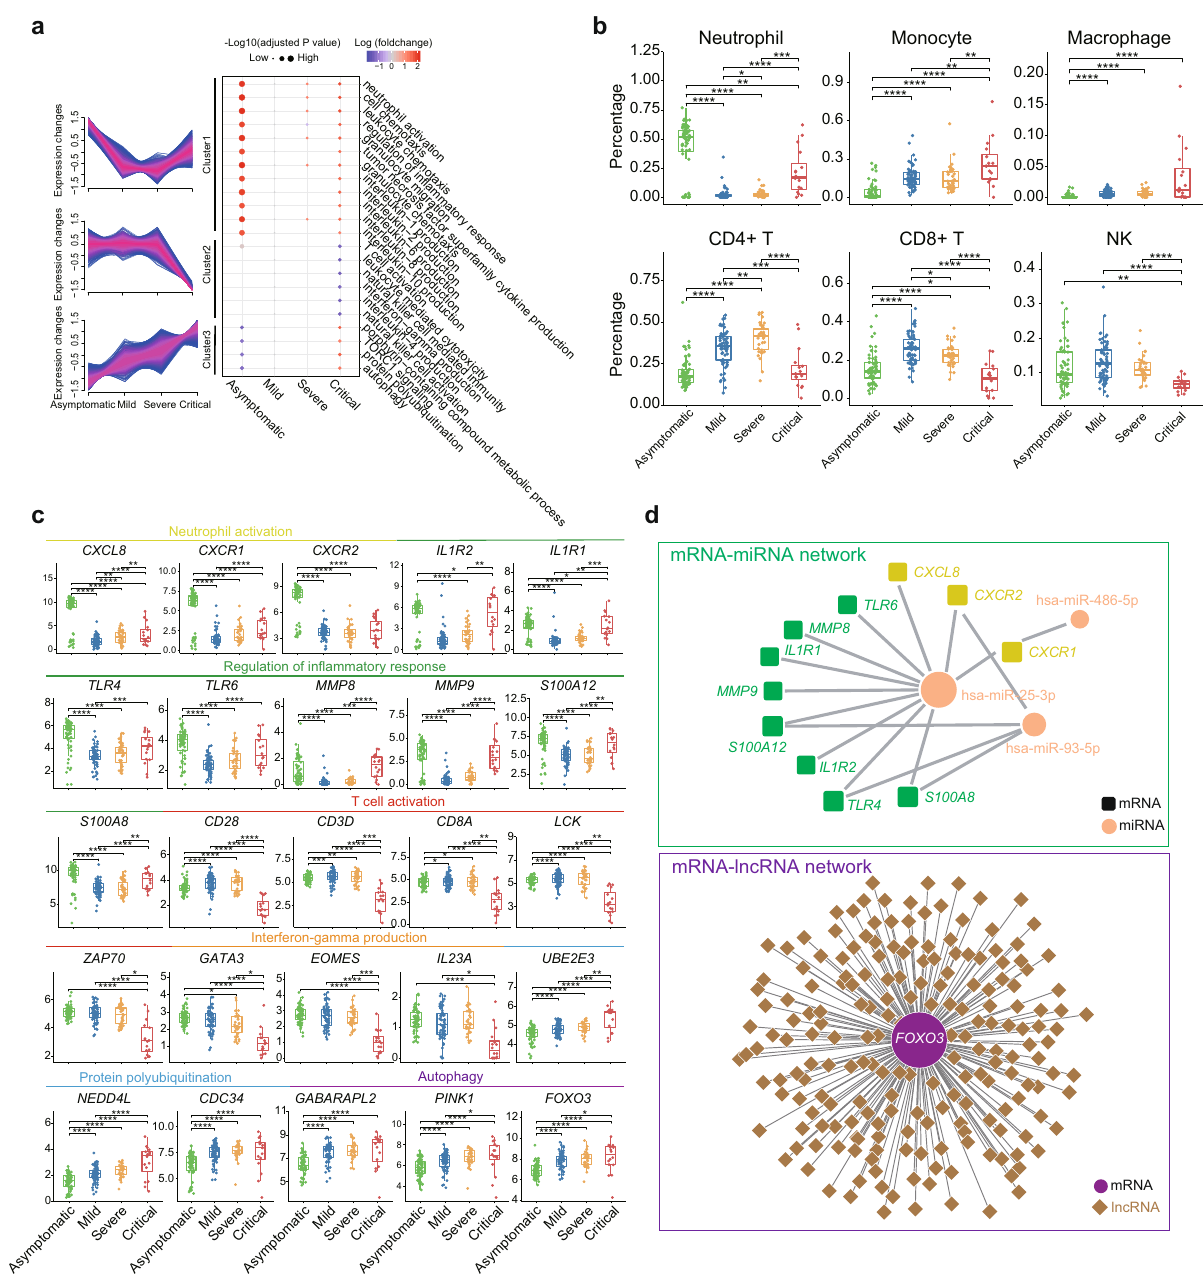
Fig. 2 Transcriptomic hallmarks of COVID-19. a Clustering of differentially expressed mRNAs and bubble plot showing GO terms enriched in each cluster across four disease severity groups. Red and blue represent up-regulation or down-regulation of genes in corresponding GO term in an investigated group compared to mild group (median of log2 (fold-changes)). Dot size represents -log10 (adjusted P values). P values were calculated using hypergeometric test (two-sided). b Estimated immune cell abundance using CIBERSORTx for asymptomatic ( n = 64), mild ( n = 64), severe ( n = 34), and critical ( n = 16) COVID-19 patients. P values were calculated using Wilcoxon signed-rank test (two-sided). c Boxplot of representative genes associated with neutrophil activation, regulation of in fl ammatory response, T cell activation, interferon-gamma production, protein polyubiquitination, and autophagy in asymptomatic ( n = 64), mild ( n = 64), severe ( n = 34), and critical ( n = 16) COVID-19 patients. We performed comparisons between arbitrary two groups. P values were calculated using the Wald test and signi fi cant P values were shown in boxplot. d mRNA-miRNA and mRNA-lncRNA interaction networks for genes mentioned in Fig. 2c. The bold lines, upper boundaries and lower boundaries of notches represent the medians, 75th percentiles and 25th percentiles, respectively. Whiskers extend 1.5 times interquartile range (IQR). * means adjusted P value ≤ 0.05, ** means adjusted P value ≤ 0.01, *** means adjusted P value ≤ 0.001 and **** means P ≤ 0.0001, if not indicated, means adjusted P value > 0.05. Multiple comparisons adjustment was performed using Benjamini-Hochberg (BH) method. Exact P value and source data were included in the Source Data fi